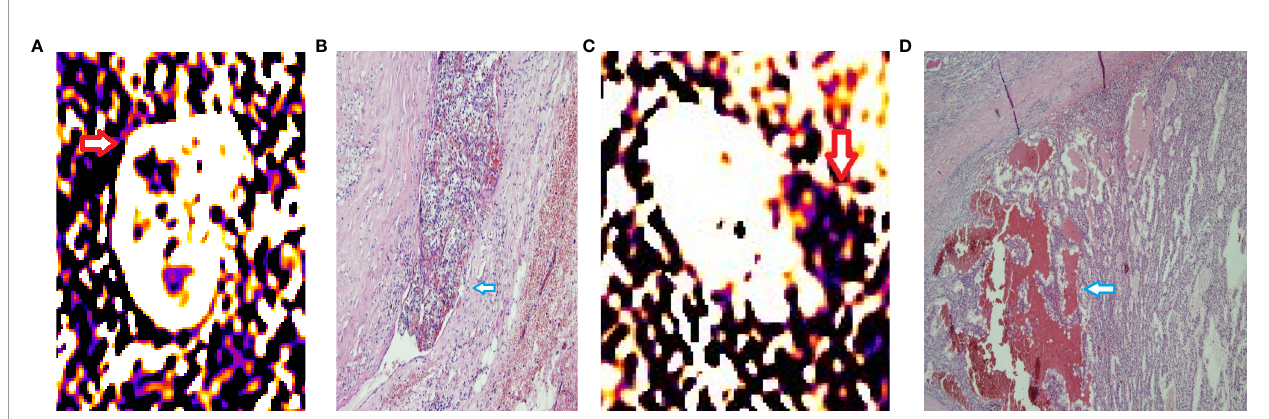
FIGURE 2 | RBF of ccRCCs with or without microvascular invasion. A 50year-old man with a mass on right kidney (A, B) . (A) RBF image showed a high-perfusion mass located on the upper section of right kidney (red arrow), with central low-perfusion, indicated the central necrosis. (B) Pathological section showed the cancer embolus (blue arrow) in the microvascular cavity. A 63year-old woman with a mass on left kidney (C, D) . (C) RBF image showed a low-perfusion mass located on the left kidney (red arrow). (D) Pathological section showed no microvascular invasion. There was hemorrhage within the tumor (blue